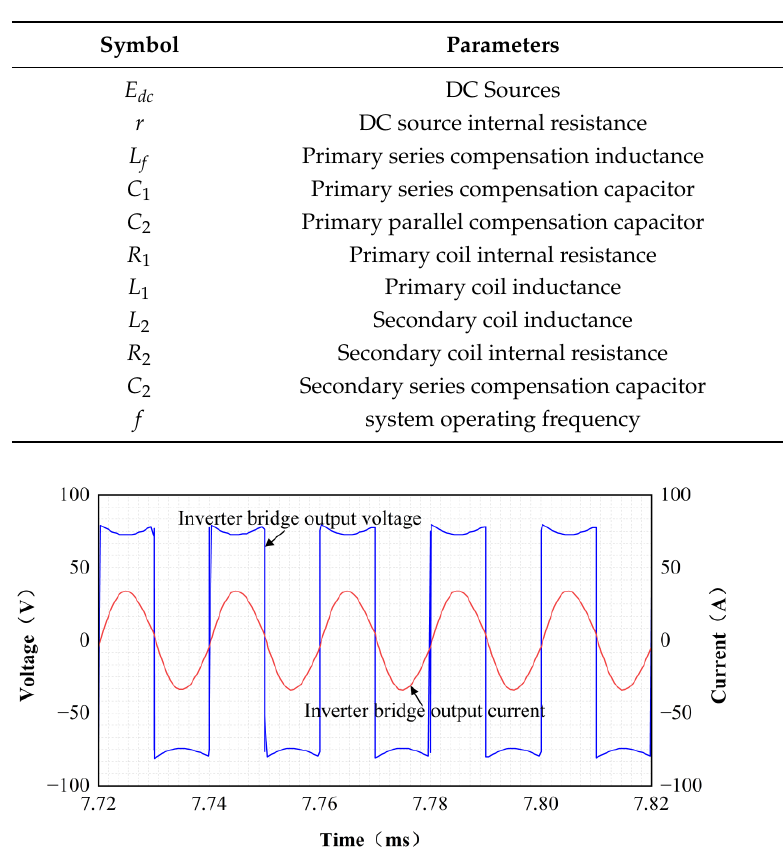
Table 2. Parameters of the MC.